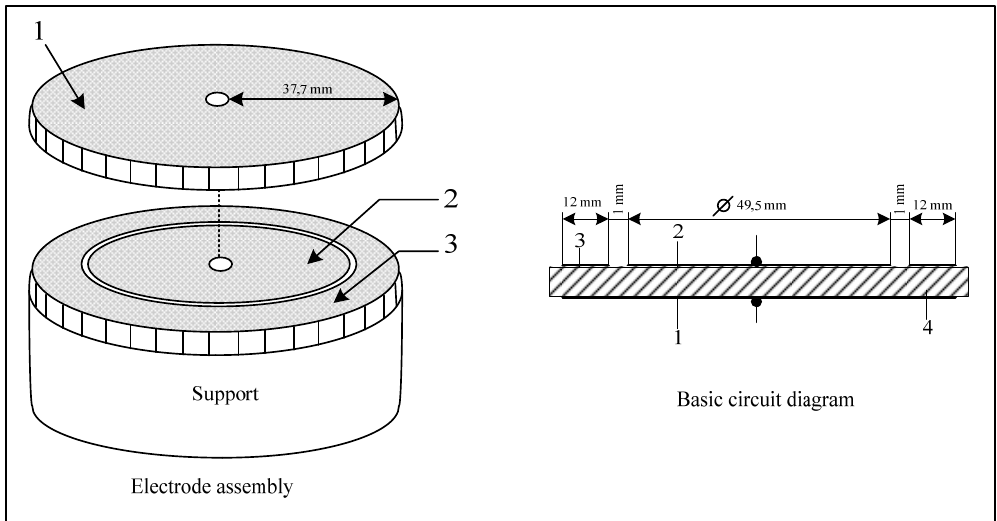
Figure 1. Overview of the capacitive test cell used for the measurement of dielectric response of the oil impregnated pressboard: 1. High-voltage electrode; 2. Measuring electrode; 3. Guard-ring and 4. pressboard